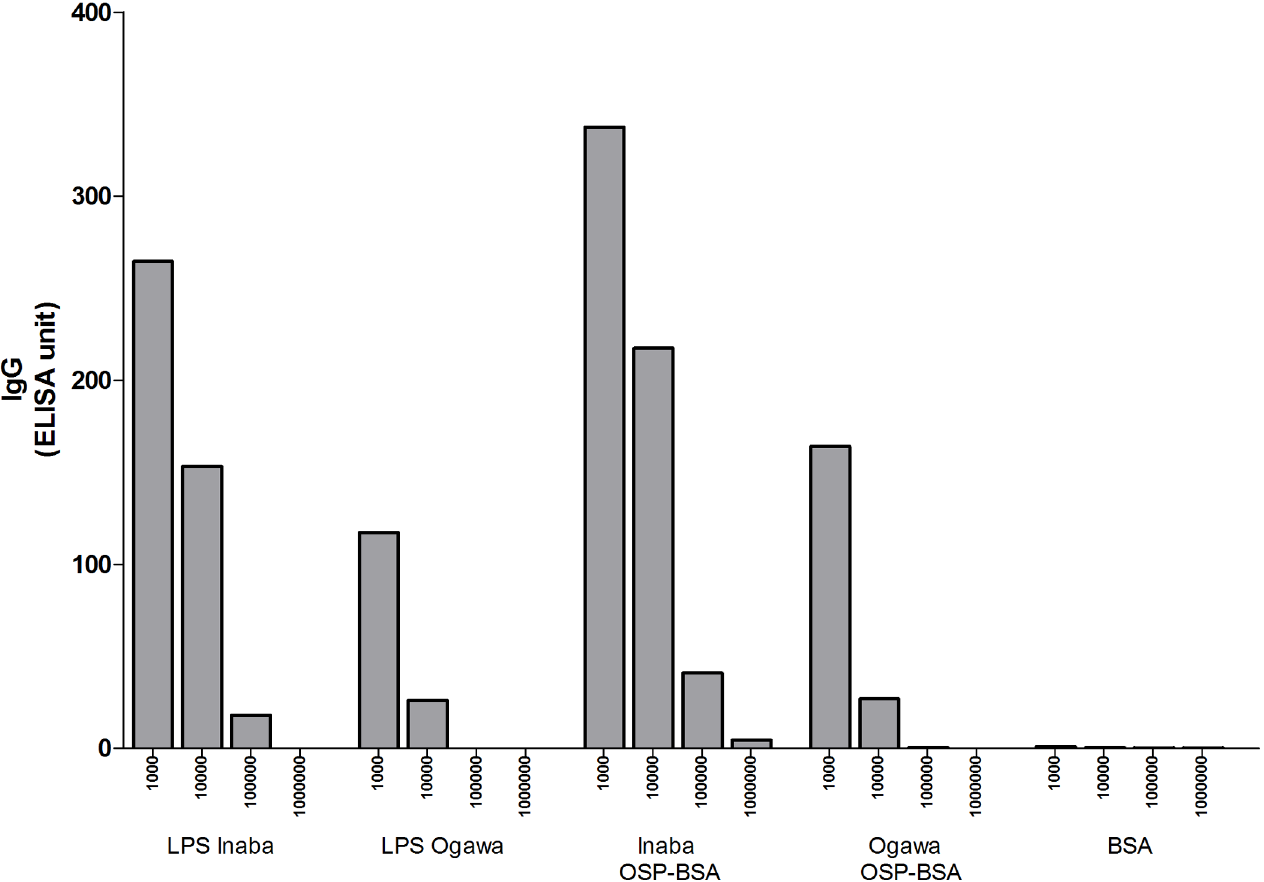
Fig 2. Immunoreactivity of the ICL-33 monoclonal antibody at 1:1,000 (114 ng); 1:10,000 (11.4 ng); 1:100,000 (1.14 ng) and 1:1000,000 (114 pg) dilutions to purified lipopolysaccharide (LPS), O-specific polysaccharide (OSP) components of V . choleare O1 Ogawa and Inaba serotypes and BSA: Bovine serum